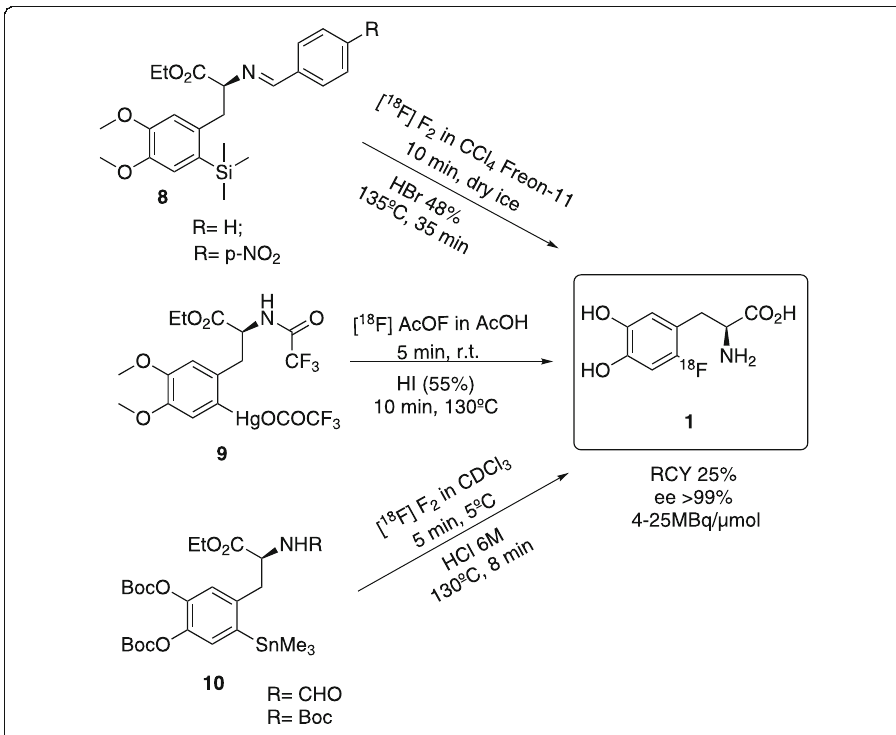
Fig. 4 Electrophilic synthesis of 6-[ 18 F]FDOPA (Diksic & Farrokhzad, 1985; Adam & Jivan, 1988; Luxen et